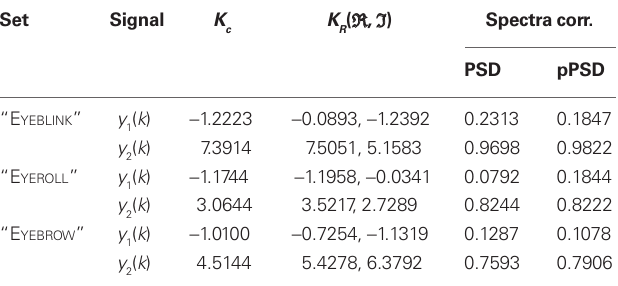
Table 4 | Normalized kurtosis values of the extracted artifacts, and the correlation coefficient of the power and pseudo-power spectra respectively with the spectra of the recorded